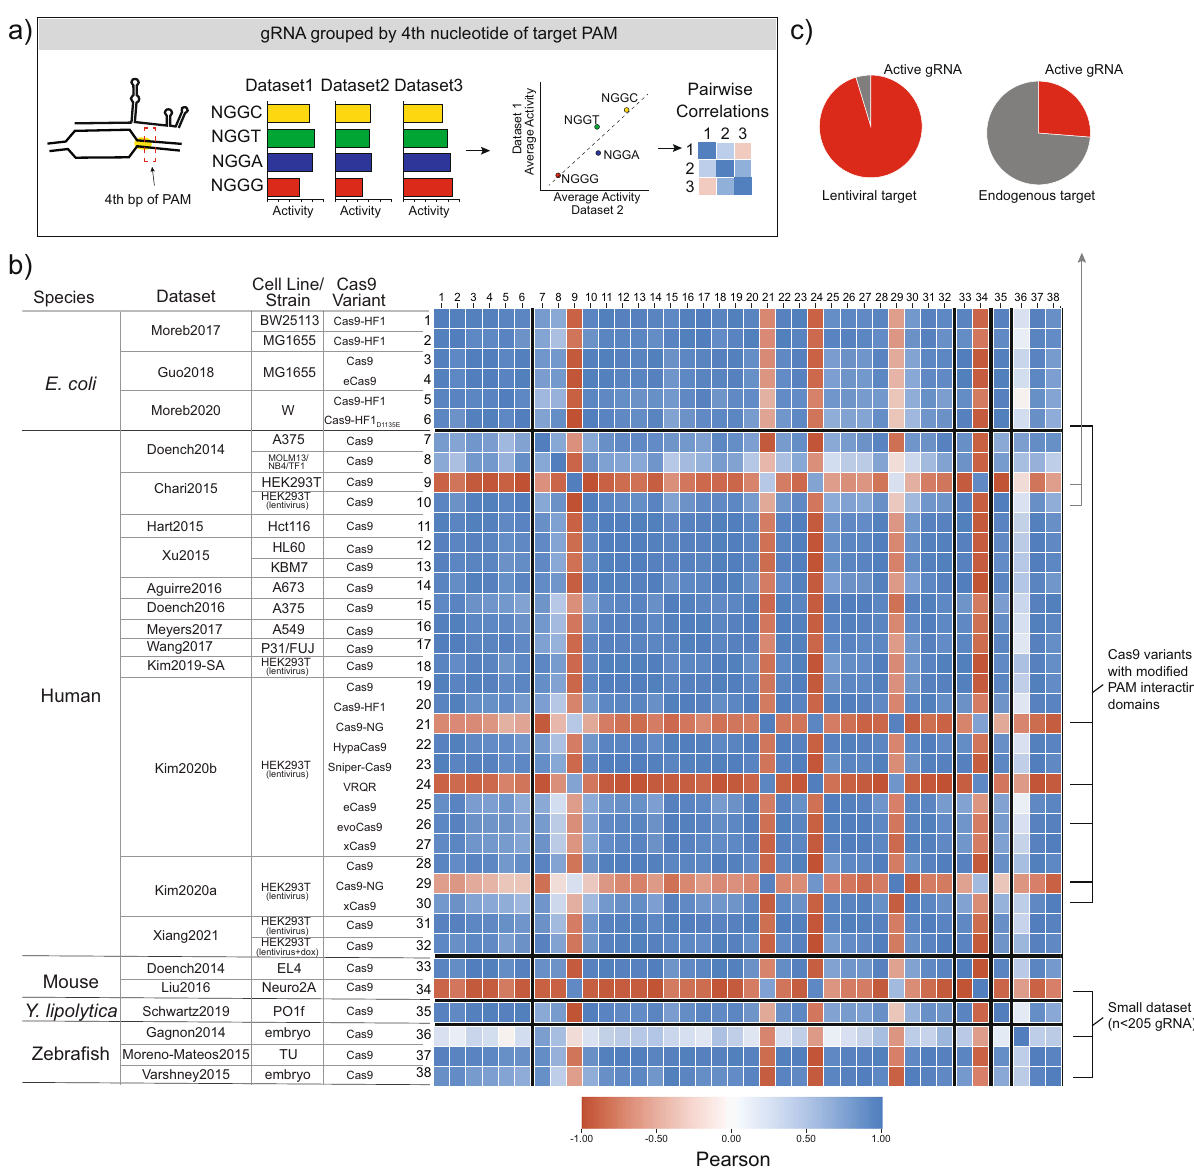
the three datasets targeting fewer than ~200 gRNA, two datasets are